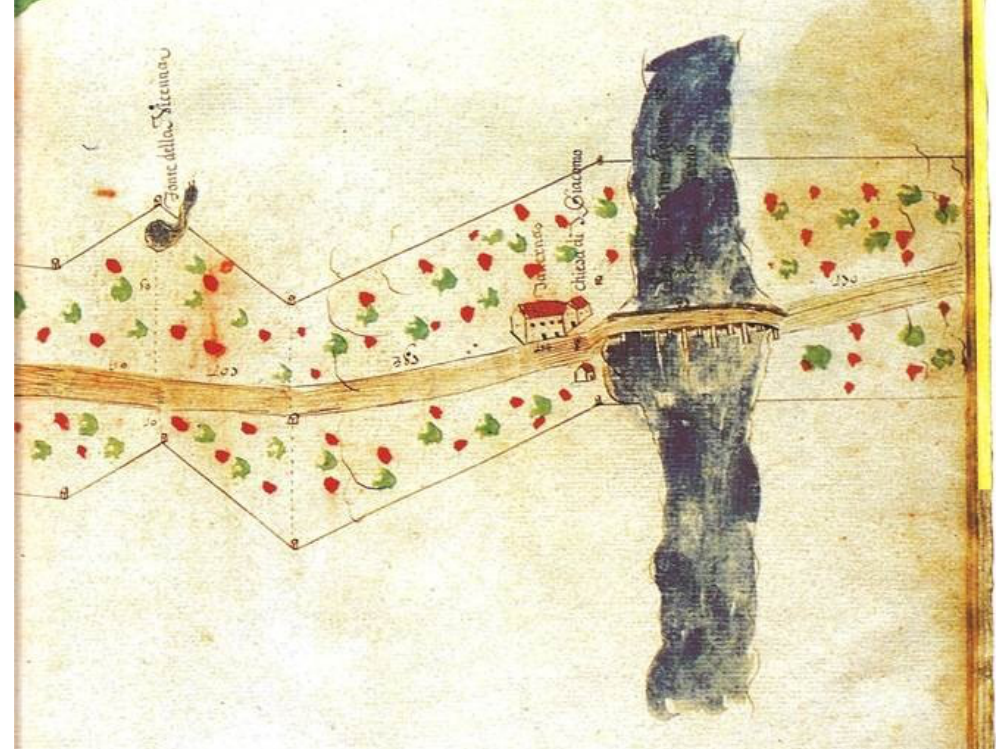
Figure 1. A sheet from the Crivelli Atlas representing the crossing of the Biferno river in the territory of Castropignano (Molise, Italy), 1712.